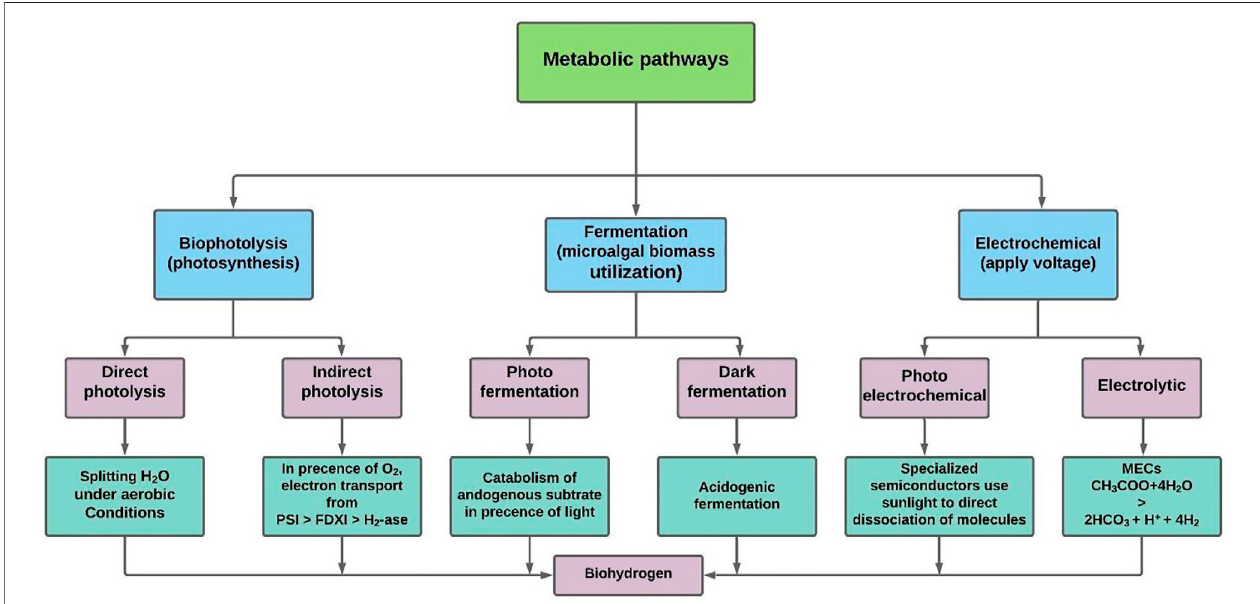
FIGURE 1 | Metabolic pathways of biohydrogen production by micro-algal biomass, modi fi ed from El-Dalatony et al. (2020). These are mainly classi fi ed into three categories: i) the photobiological process through which biohydrogen is produced via direct and indirect photolysis in the microalgae; ii) fermentation; and iii) the electrochemical process that comprises photoelectrochemical and